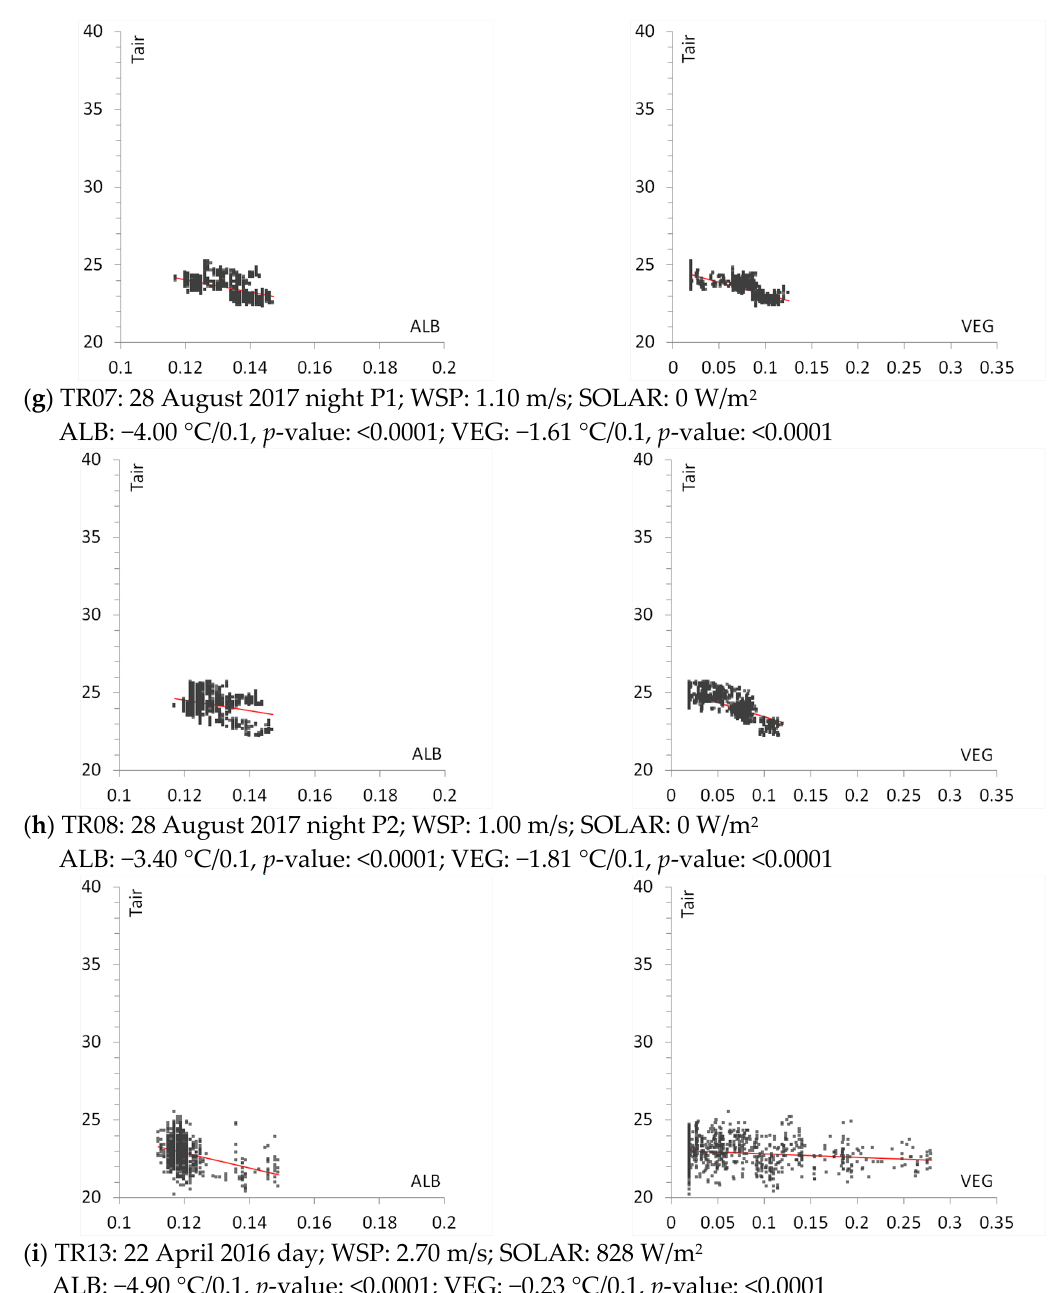
Figure 9. ( a – i ): Observed air temperature (from mobile transects) versus neighborhood-scale albedo and canopy cover in the downtown area. Vertical axis ( T air ) is air temperature (°C); horizontal axis is albedo (ALB) or canopy cover (VEG), unitless.